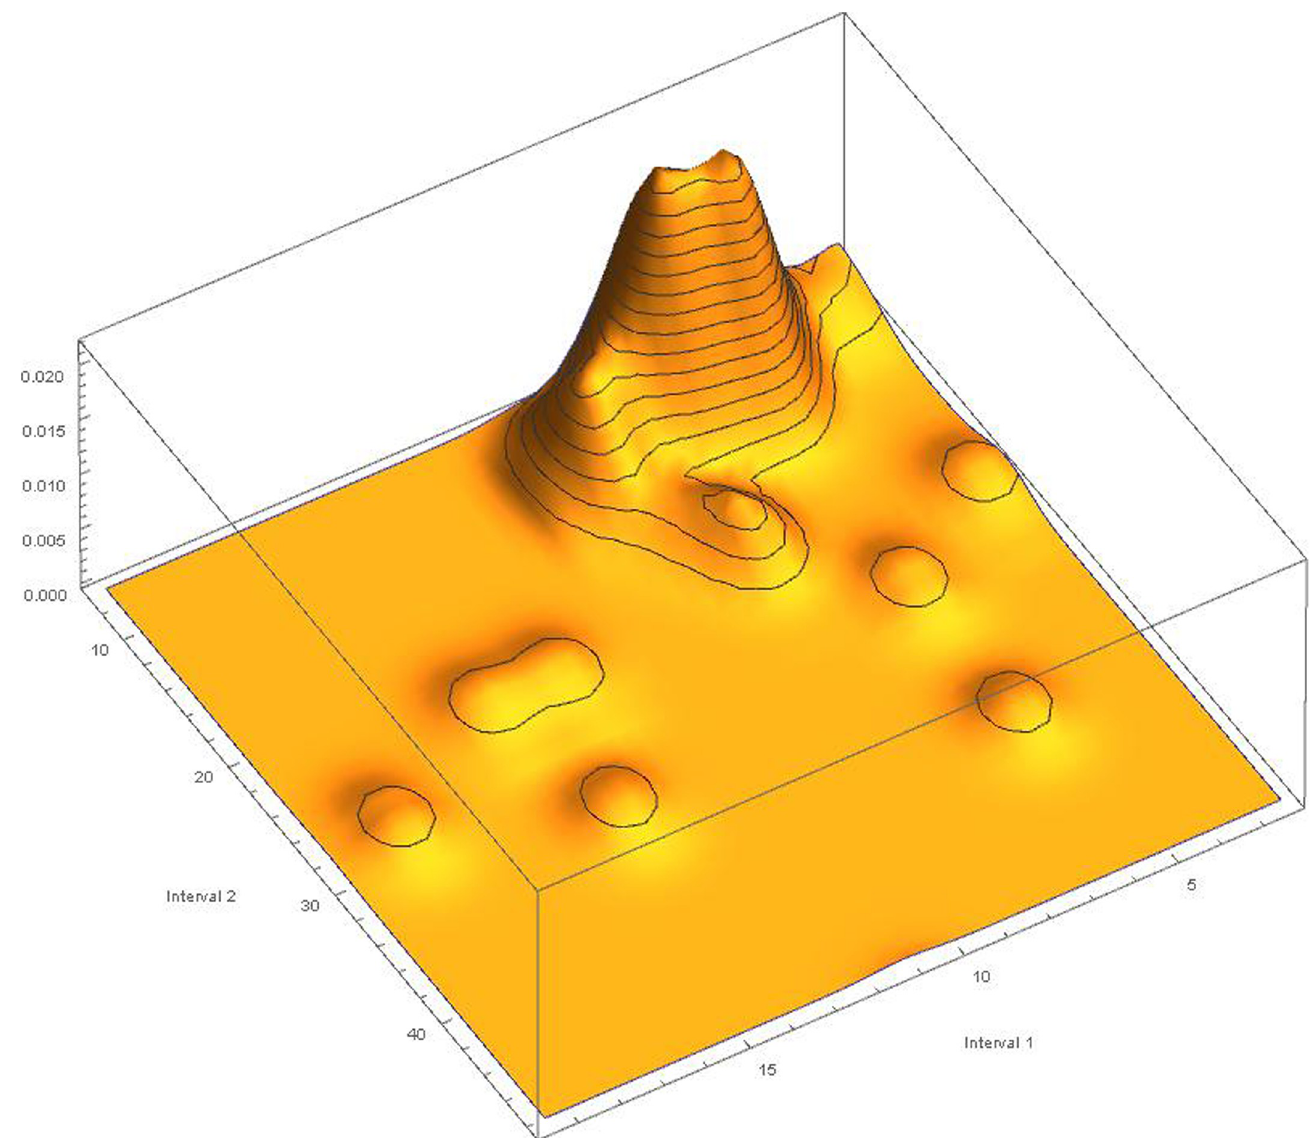
Fig 12. Histogram of the clustering of three pairs of intervals that have the same pandemic spreading times. Such pairs tend to group mainly in a well-defined shared temporal space.